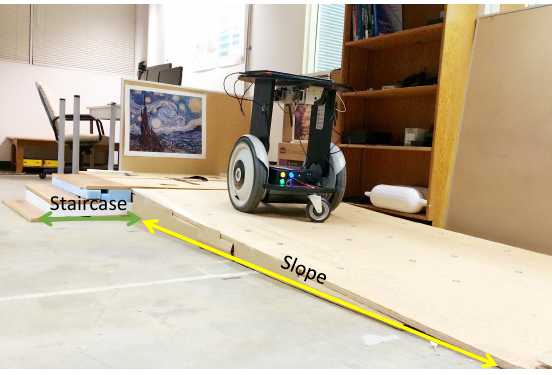
Figure 1. An illustration of a wheel robot navigating in a challenging